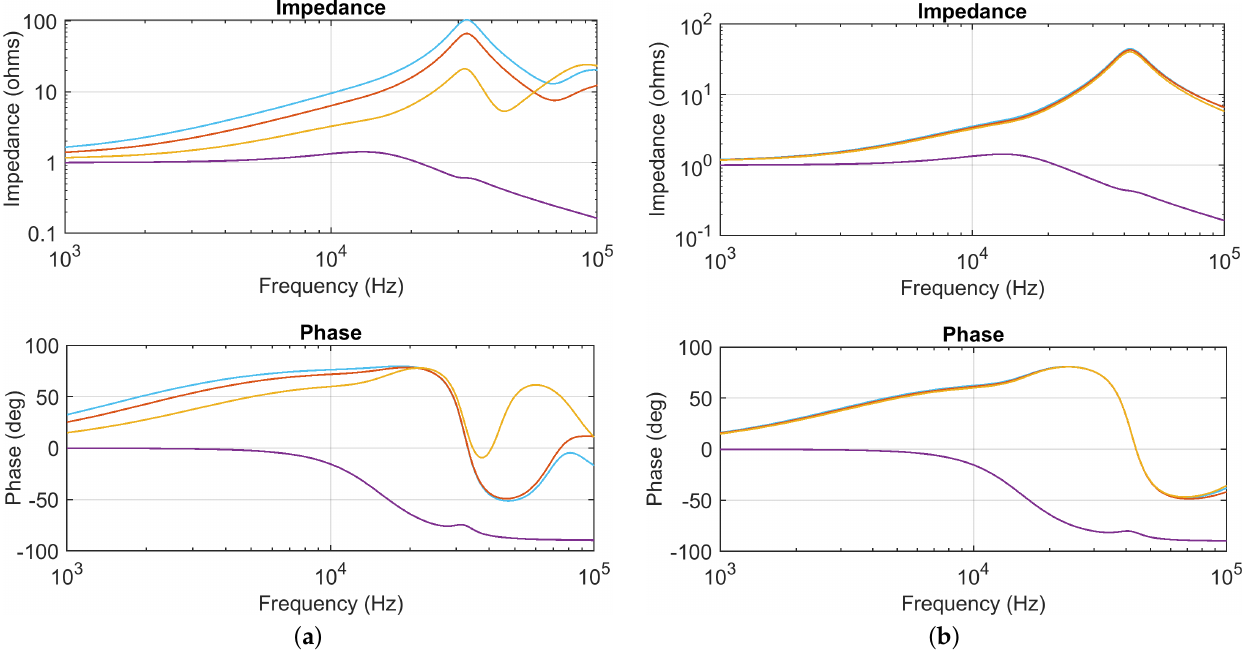
Figure 12. ( a , b ) Estimate of the grid impedance seen at the three source injection points (from I s ,1 , light blue, I s ,1 , dark orange, and I s ,1 , yellow), plus the impedance at the bus intake, node 0